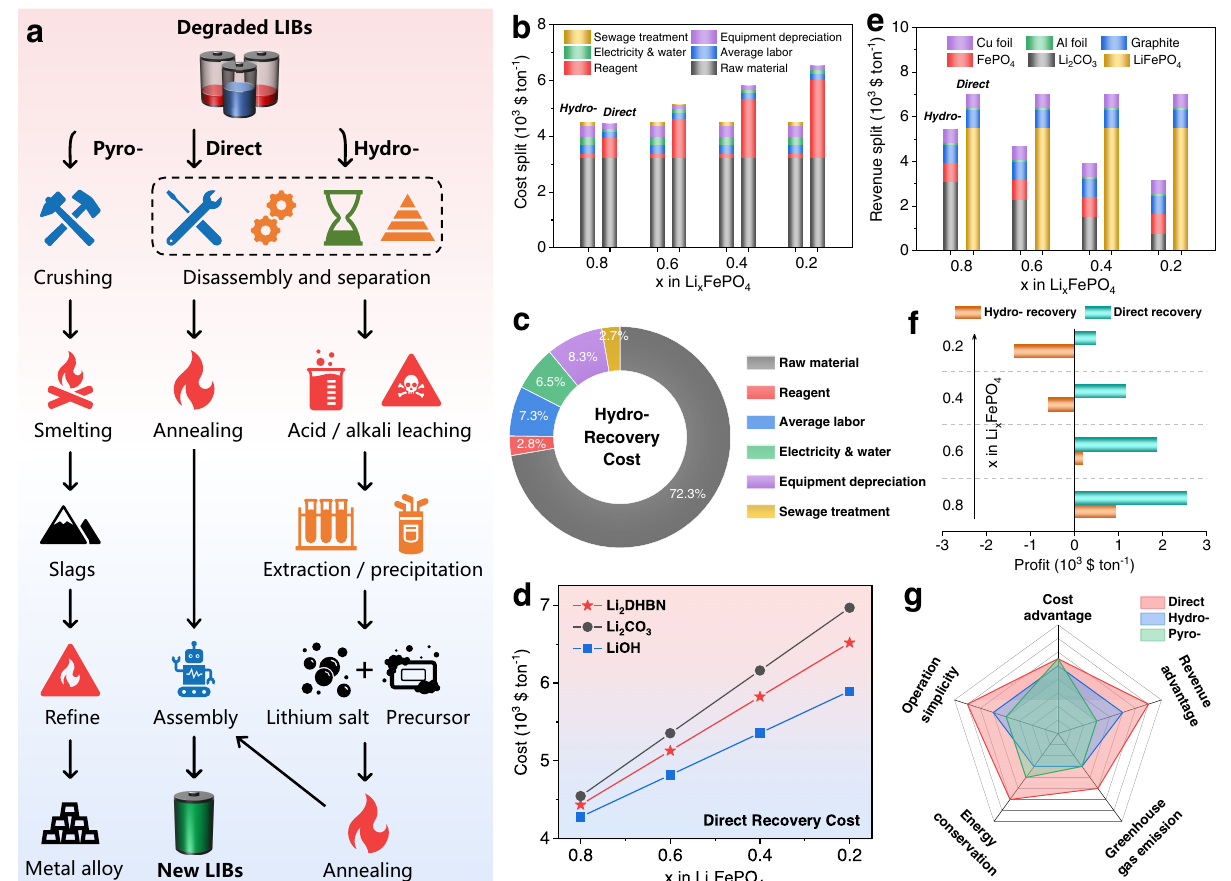
Fig. 5 | Techno-economic analysis of different battery recycling technologies. a Schematic of the pyro-, hydro- and direct routes. b Cost and e revenue splits based on the hydro- and direct recovery routes for different degraded LFP bat- teries. The residual lithium content indicates the degree of failure of the LFP cathode since this factor has a signi fi cant effect on the economic analysis. c Pie